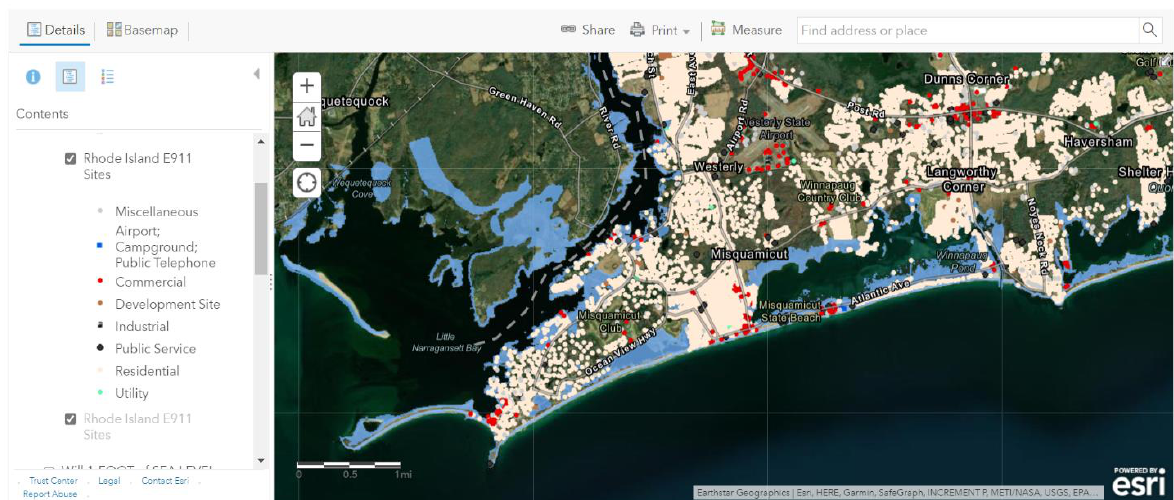
Figure 2. Westerly, RI study area showing the location of structures from the E911 Enhanced emergency data (see legend for structural type: white dots—residential structures, red dots—commercial structures). Background shows area impacted by 5 ft of SLR (light blue).